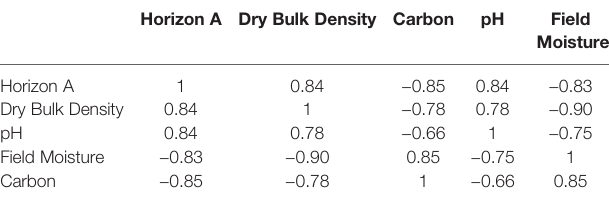
TABLE 3 | Spearman ’ s rank correlation of soil properties with statistically signi fi cant correlation to Pasteuria spp. community